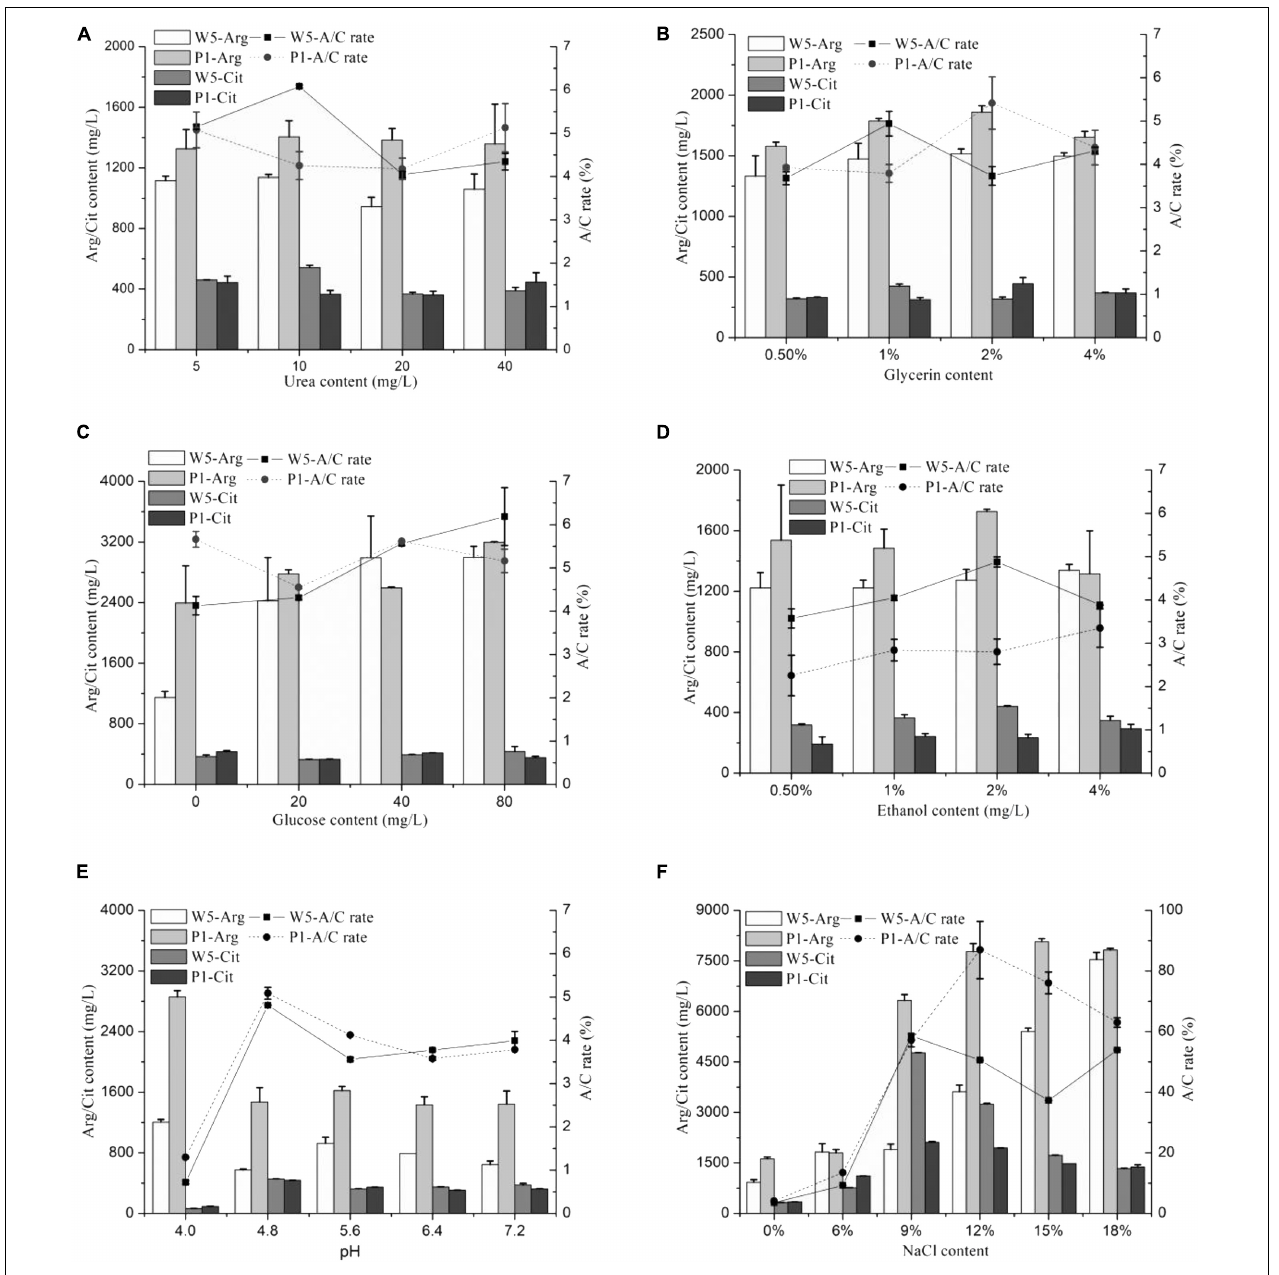
FIGURE 1 | The effect of medium condition [ (A) urea, (B) glycerin, (C) glucose, (D) ethanol, (E) pH, and (F) NaCl] on citrulline accumulation of W. confusa and P. acidilactici (W5, W. confusa ; P1, P. acidilactici ; Arg, arginine; Cit, citrulline; similarly